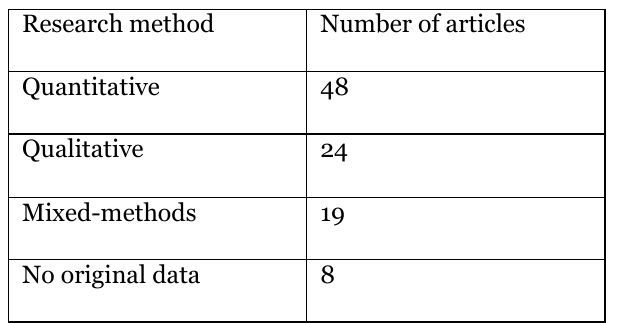
Research Methods for the